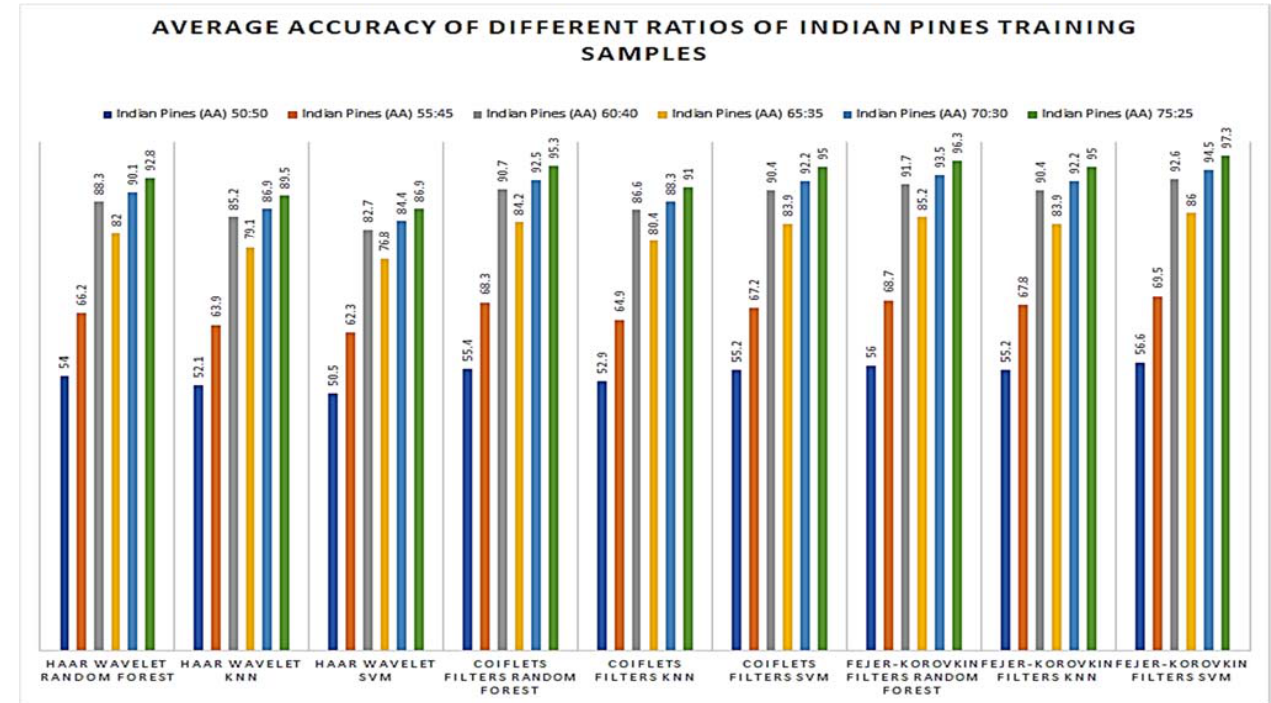
Figure 12. Average accuracy of different ratios of Indian Pines training samples (plot of different types of training and testing samples).